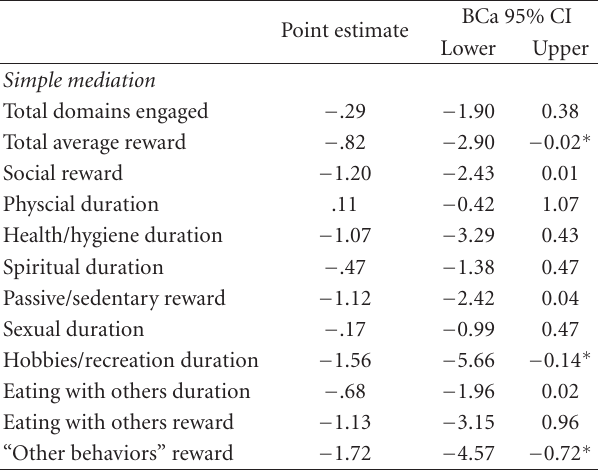
Table 2: Indirect e ff ects of gender on depression through duration and reward values of overt behaviors using bootstrapping technique ( N = 82: 5000 bootstrap